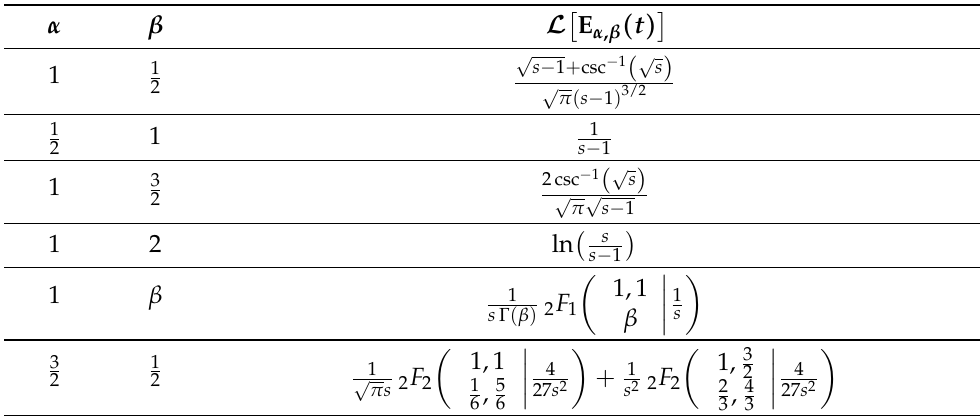
Table A3. The Laplace transforms Mittag-Leffler functions derived for some values of parameters α and β by using